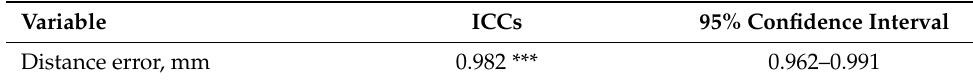
Table 3. Test-retest reliability of the SCT-VR ( n = 30).